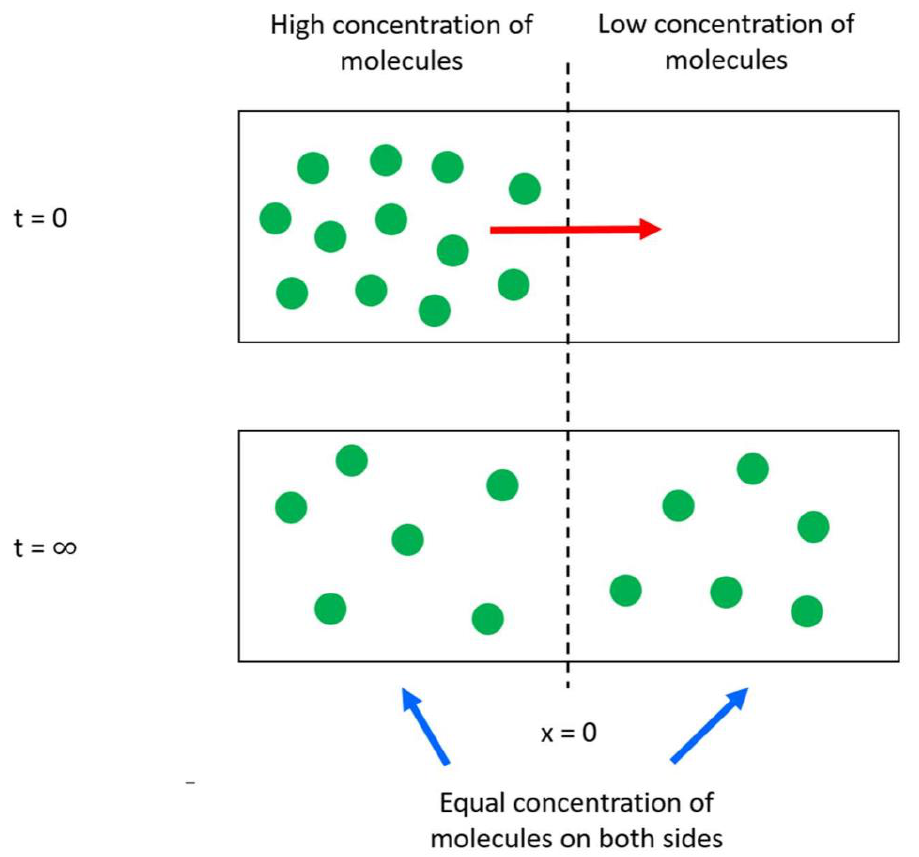
Figure 11. Visual representation of how molecules diffuse in solution from a high concentration to a low concentration across an arbitrarily defined point (x = 0) after some period of time (t = ∞) [289]. The red arrow indicates the direction of translational motion as the molecules (green) move from an area of higher concentration (left) to an area of lower concentration (right) [287].